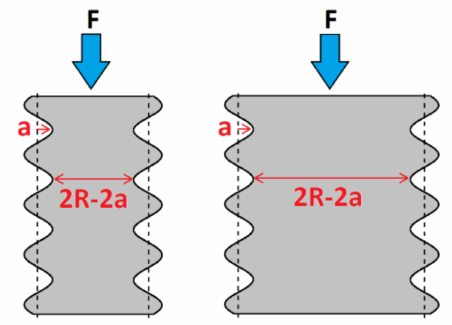
Figure 9. Variation of the effective beam section due to surface roughness, with F the applied